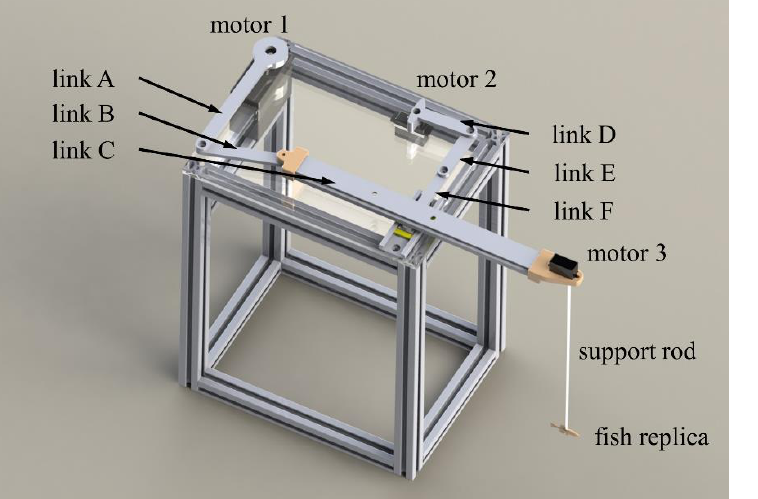
Figure 2 . Computer aided design of the robotic platform. A 3D-printed replica was attached to the bottom end of the support rod and was passively translated on a horizontal plane, along desired trajectories while imposing an oscillatory motion. [Reproduced from (Phamduy et al.,